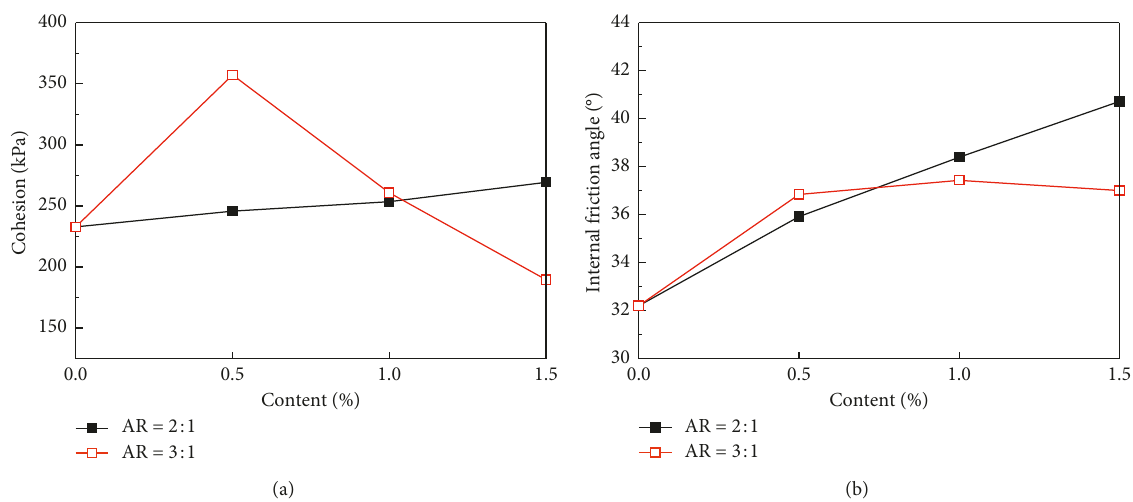
Figure 9: Variations in cohesion and internal friction angle under the effects of content and aspect ratio: (a) aspect ratio of 2:1; (b) aspect ratio of